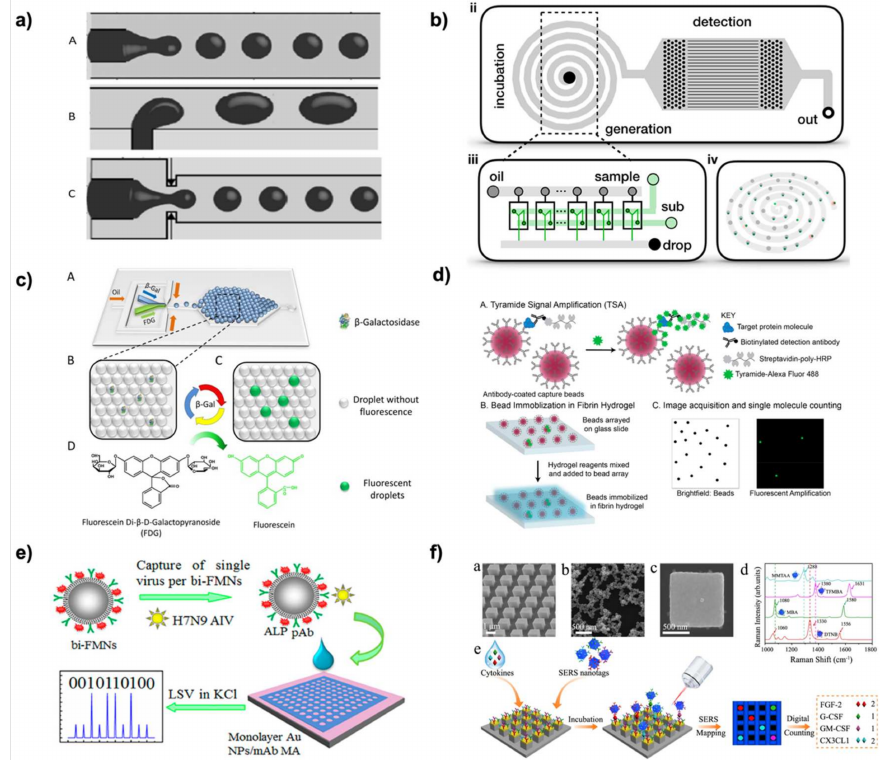
Figure 2. ( a ) Schematics of most common droplet formation methods: Co-Flow ( A ), T-Junction ( B